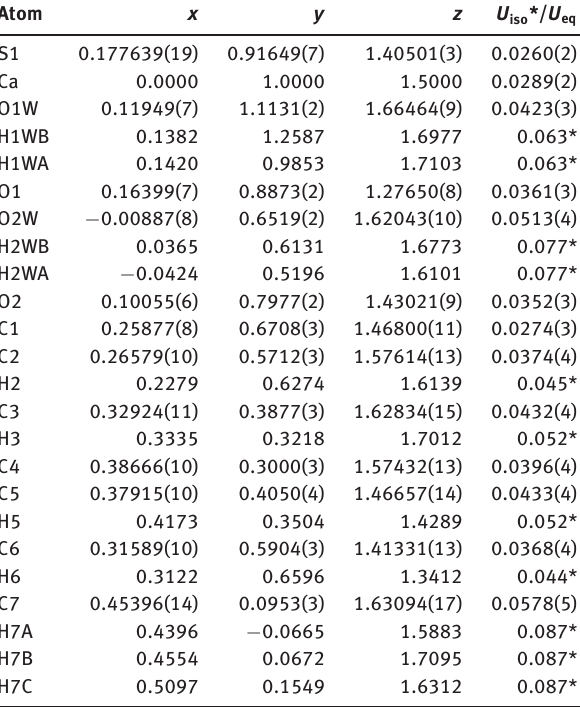
Table 2: Fractional atomic coordinates and isotropic or equivalent isotropic displacement parameters (Å 2